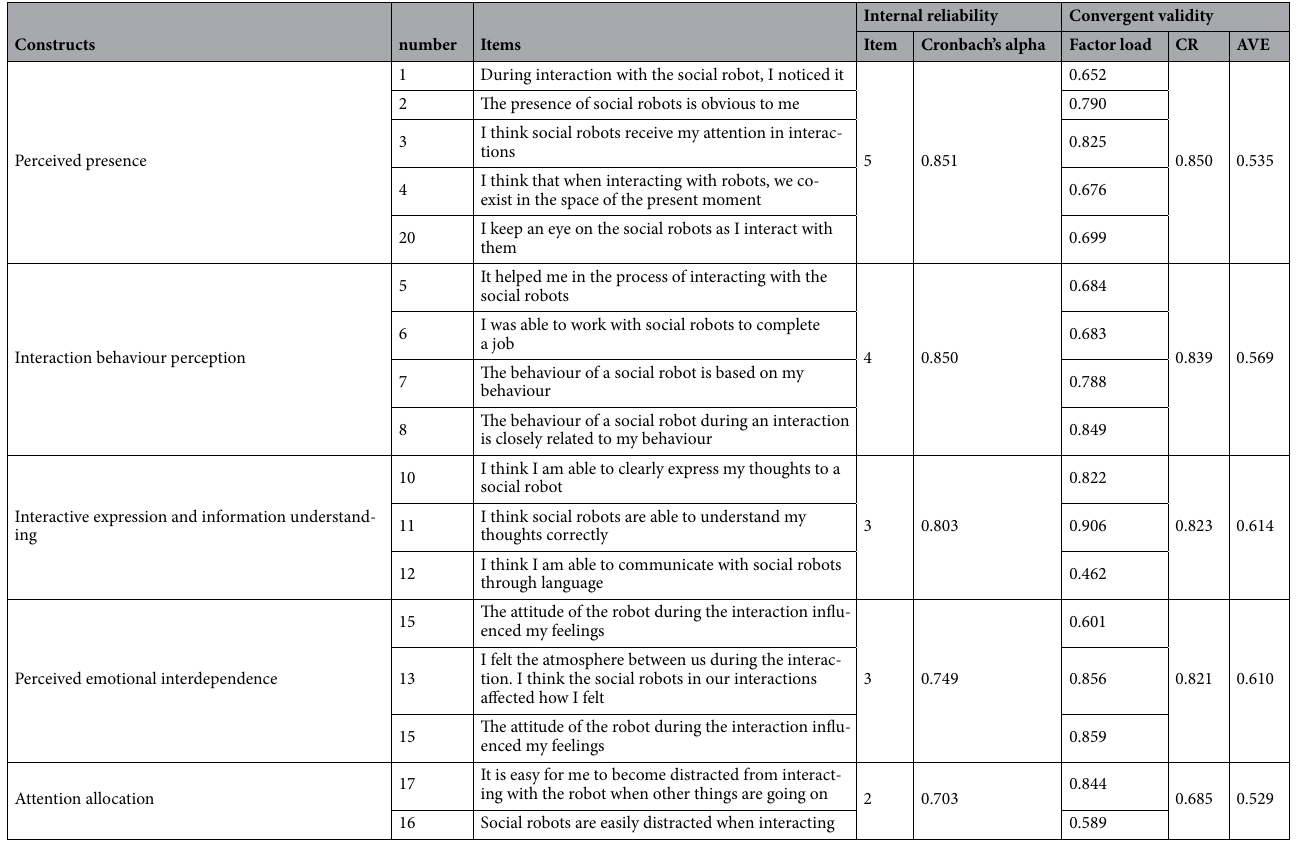
Table 7. Study 2: Scale validity analysis of the pilot questionnaire